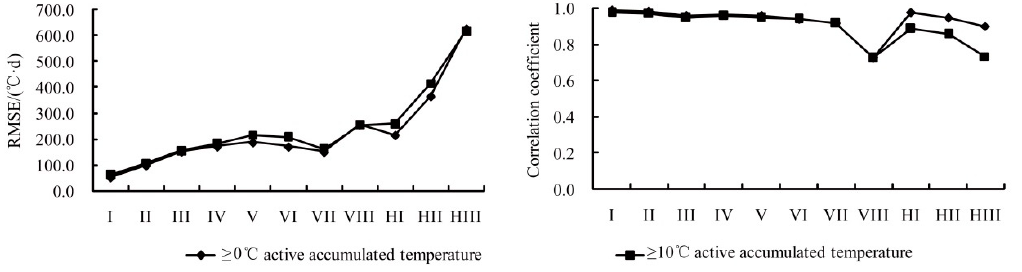
Figure 14. Root mean-square error (left) and correlation coefficient (right) of ≥ 0 °C ( A ) and ≥ 10 °C ( B ) active accumulated temperature.